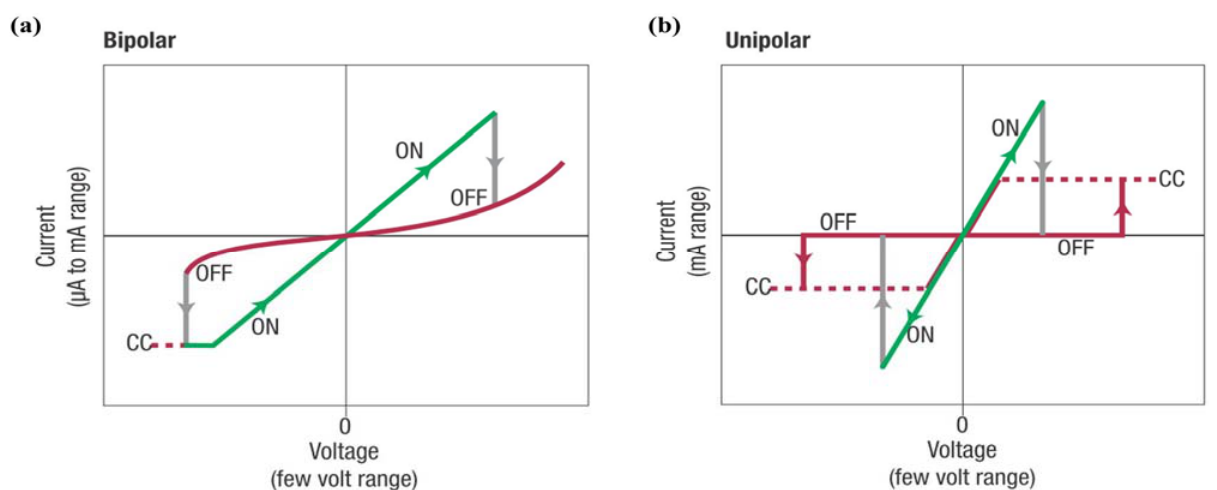
Figure 18. Classification of the switching characteristics in a voltage sweeping experiment ( a ) bipolar switching; ( b ) unipolar switching (cited from the paper of WaseR et al.